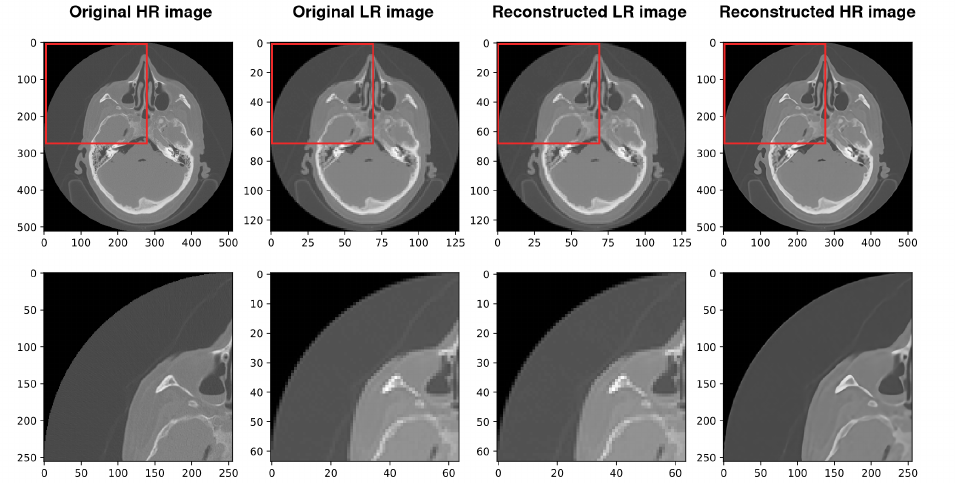
Figure 8. Results of the whole procedure of our architecture. From the left, the first image shows the original high-resolution (HR) image. The second shows the original low resolution (LR). The third image shows the reconstructed low resolution (LR) and the last shows the reconstructed high resolution (HR). The best PSNR of reconstructed HR in comparison with original HR is 34.865.